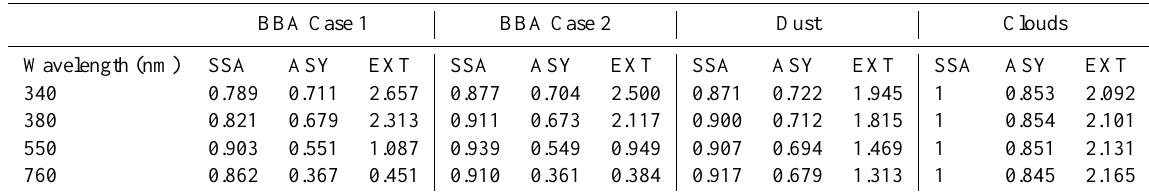
Table 2. Aerosol and cloud optical properties from the Mie calculations. SSA: single scattering albedo, ASY: asymmetry parameter, EXT: extinction